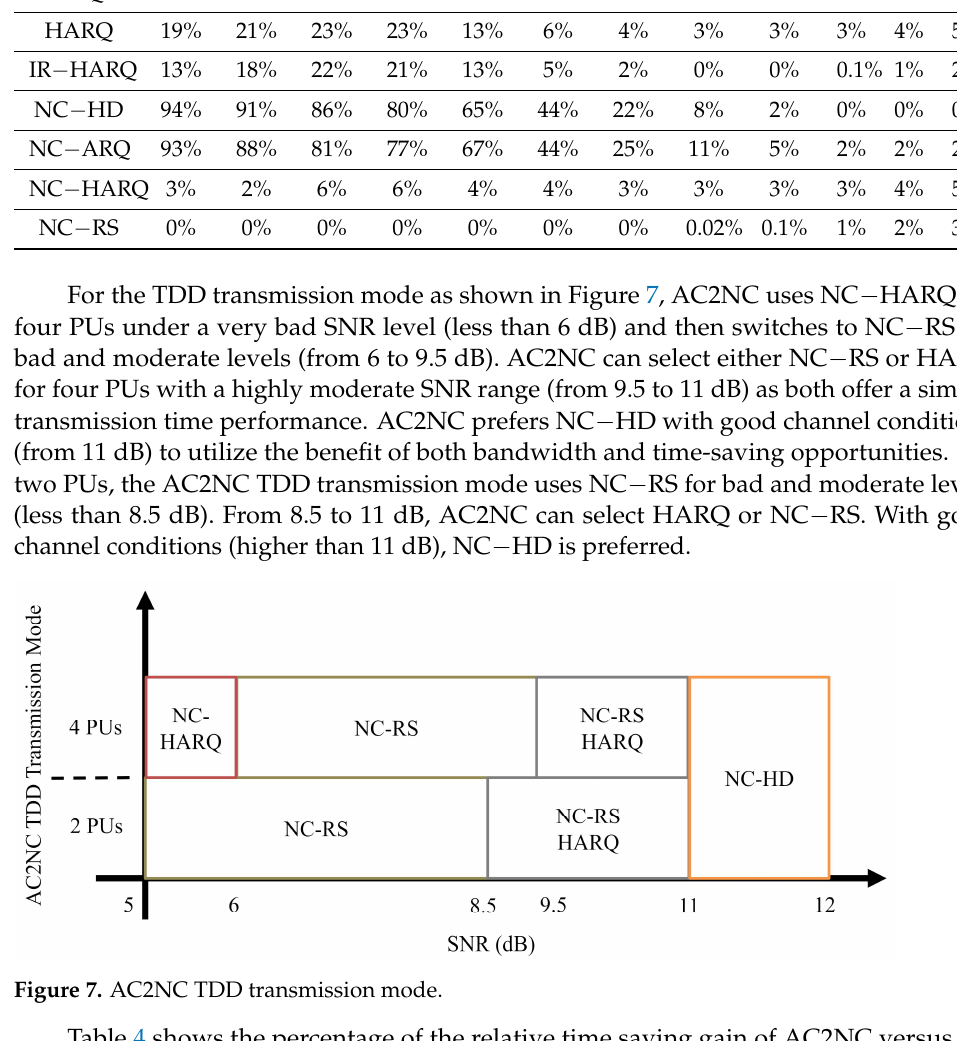
Table 3. AC2NC relative bandwidth saving gain—four PUs.